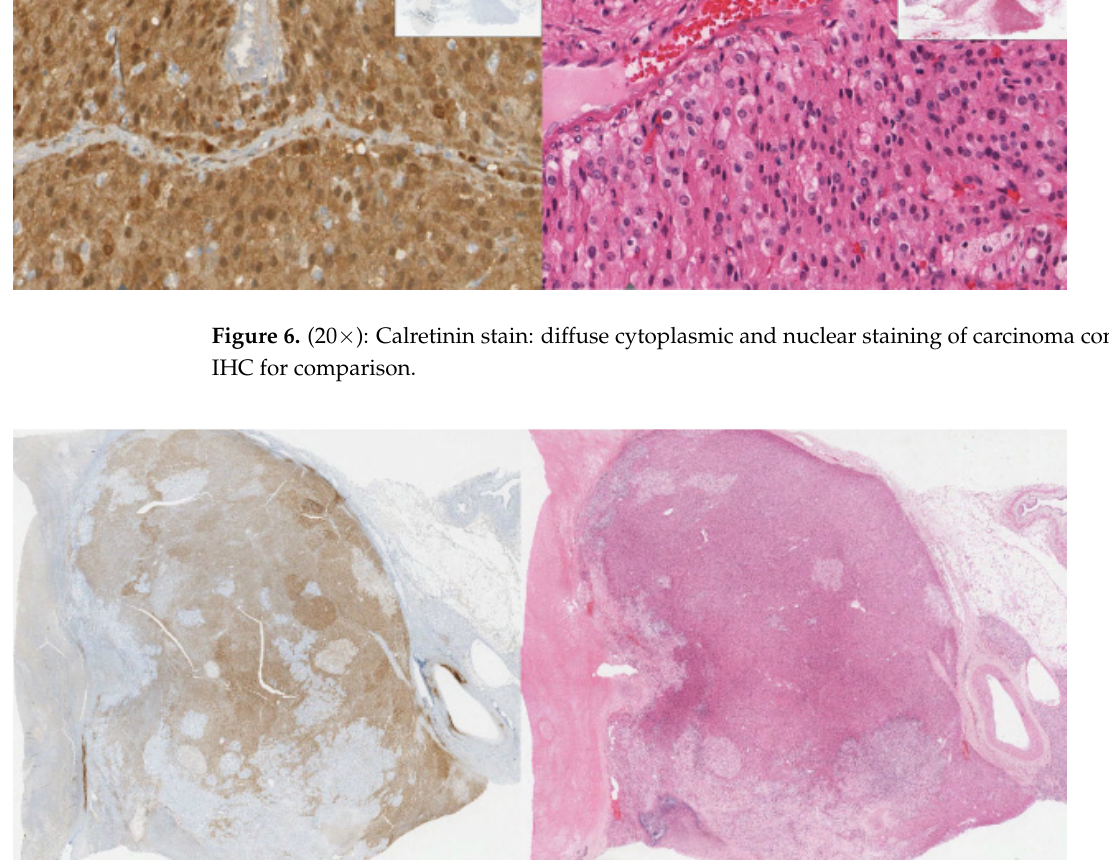
Figure 7. (10x): Synaptophysin stain: cytoplasmic and staining of carcinoma component. IHC for comparison.